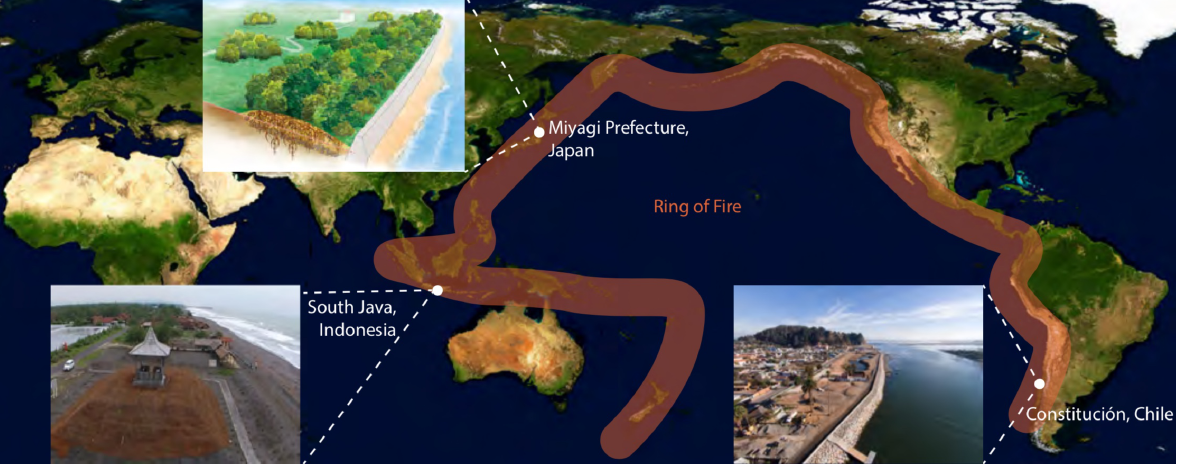
Figure 2. Map of the Ring of Fire , a long coastal stretch that is most likely impacted by large tsunamis. Some tsunami mitigation parks are being constructed in South Java, Indonesia (Image: Indonesia Ministry of Marine Affairs and Fisheries), Miyagi Prefecture, Japan (Image: the Morino Project), and Constitución, Chile (Image: Architect Magazine). Adapted from the work in